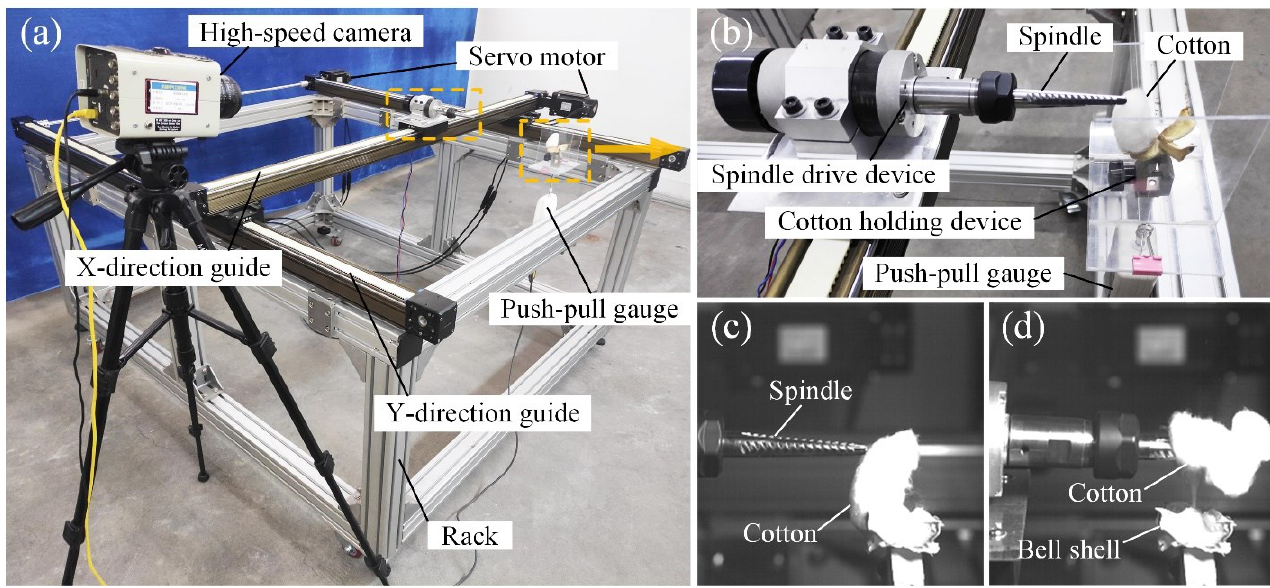
Figure 3. Spindle picking performance test bench: ( a ) the overall structure of the test bench, ( b ) the partial structure of test bench, ( c ) spindles come into contact with cotton, and ( d ) cotton and boll shell are completely separated.